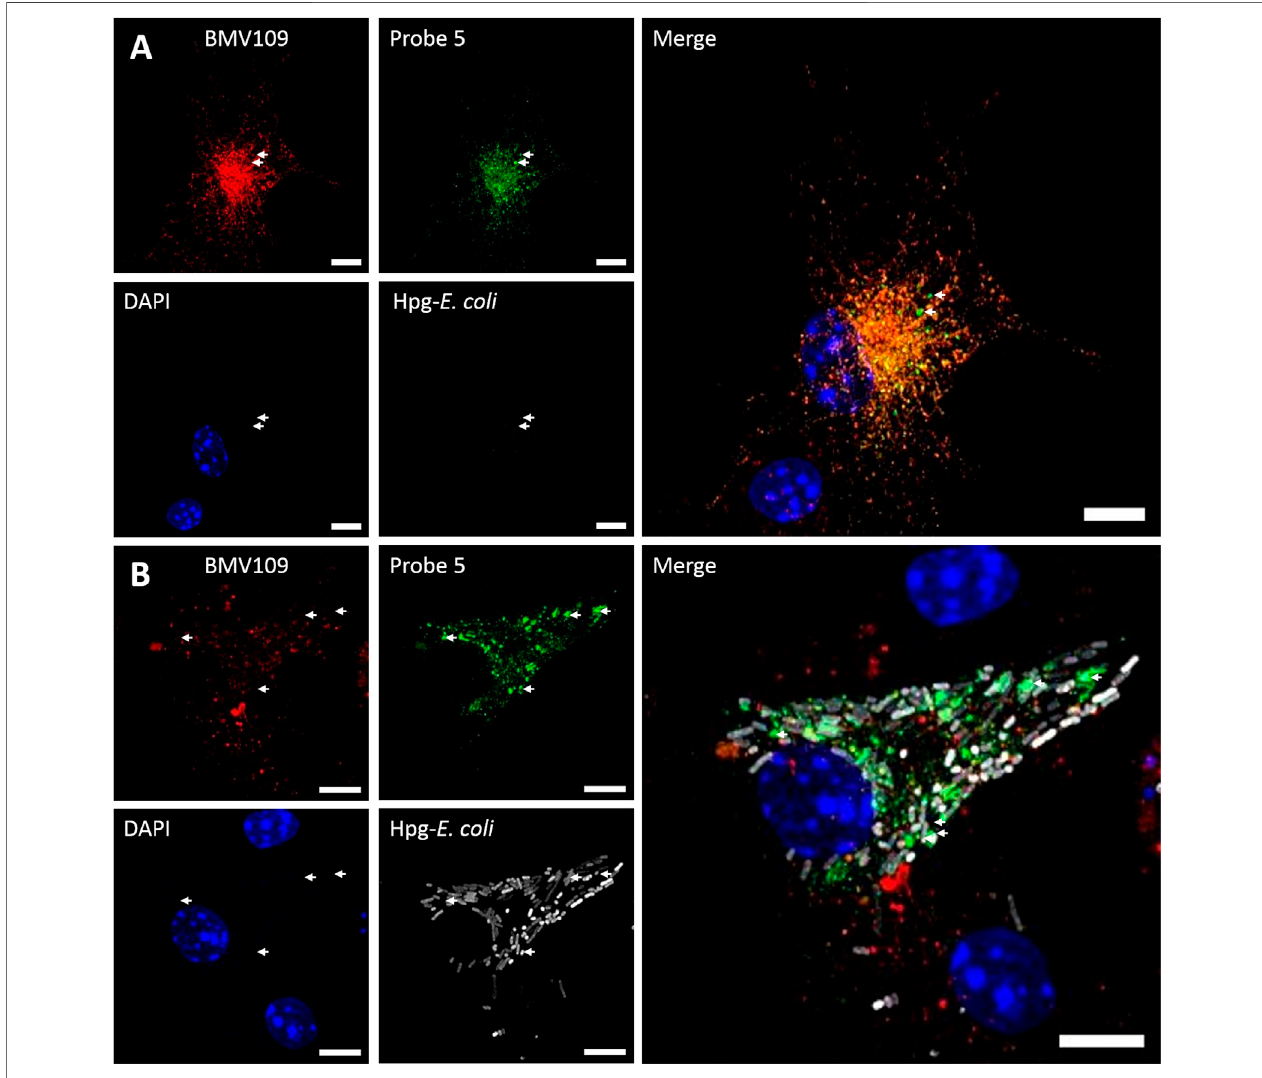
FIGURE5 | Dual click labeling in confocal microscopy (A) Naïve BMDCs (at time point 0) were treated subsequently with probe 5 (green) for1 h and BMV109(red) for 1 h, and probe 5 was visualized through click chemistry (B) BMDCs were treated with Hpg-labelled E. coli (white) for 3 h followed by probe 5 (green) and BMV109 (red) labeling ensued by tandem click chemistry. Specialized Cat S vesicles are annotated with white arrows. Scale bar represents 5 µm.